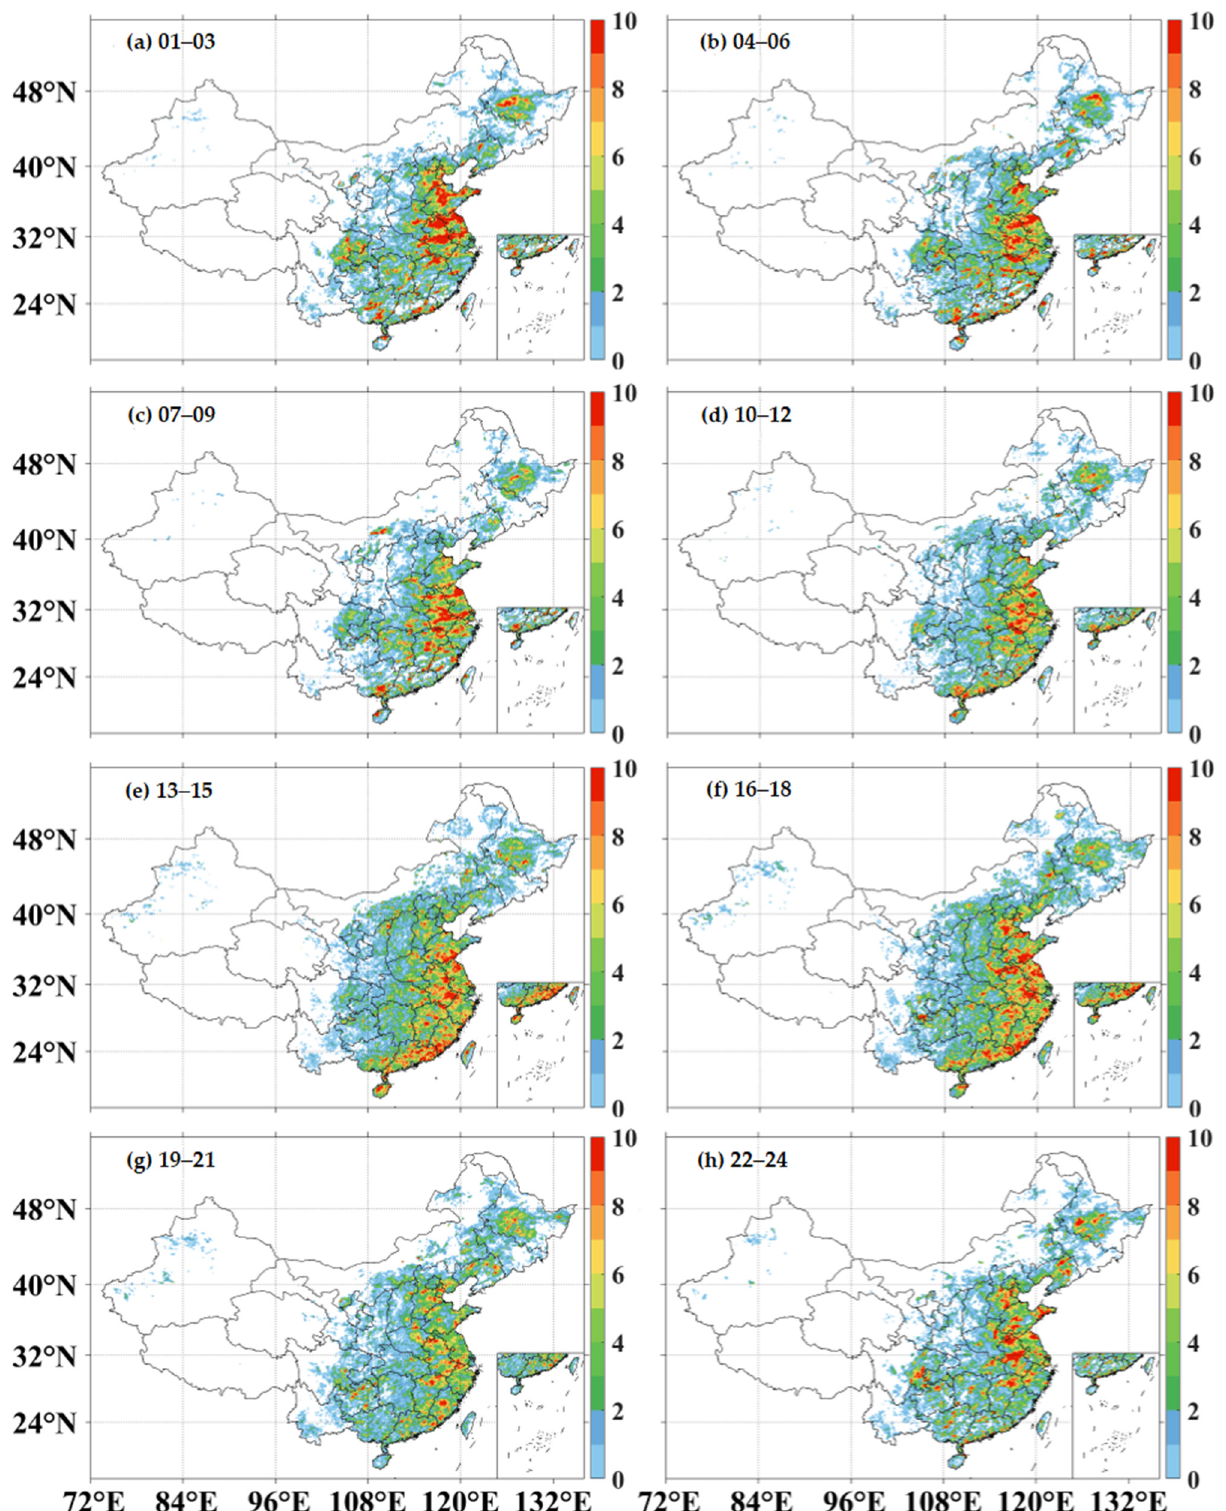
Figure 9. Diurnal variation of frequency (%) distribution of convective precipitation for period 01–